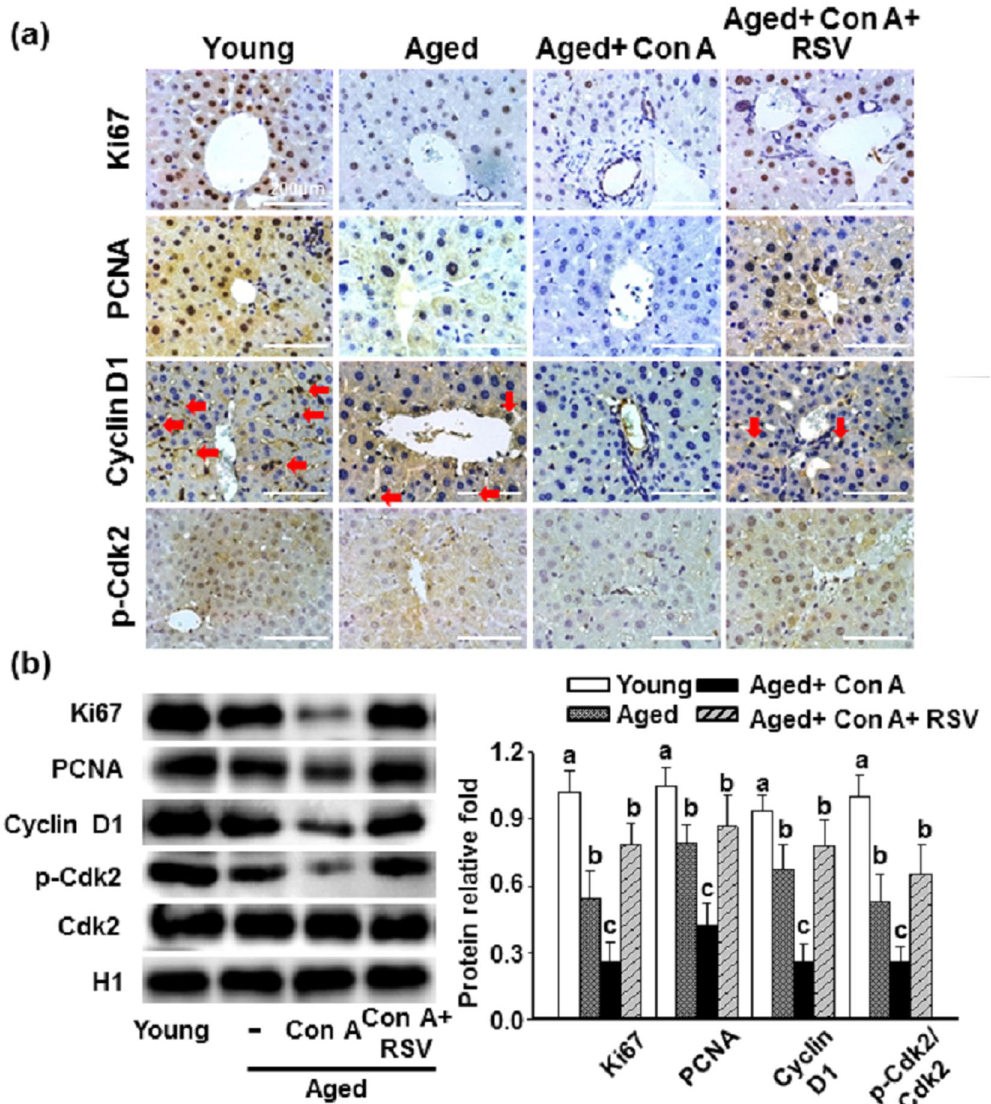
Figure 6. Effects of resveratrol on impairment of liver regeneration in aged mice treated with Con A. ( a ) Representative IHC stain for Ki67, PCNA, cyclin D1, and phosphorylated Cdk2; dark brown color, red arrows depicted sites of cyclin D1. The results are shown at 200 × magnification and the length of scale bar was indicated as 200 μ m. ( b ) Hepatic protein levels of Ki67, PCNA, cyclin D1 and total and phosphorylated forms of Cdk2 were determined by Western blotting. The results are expressed as the means ± SEMs from three independent measurements. Different letters indicate statistically significant differences (p < 0.05) between